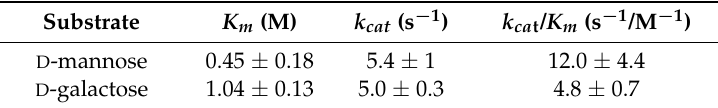
Table 2. Kinetic parameters of cellobiose 2-epimerase from R. marinus for D -mannose and D -galactose. Tests were performed at pH 6.3 and 70 ◦ C. Data represent the mean of three experiments with standard